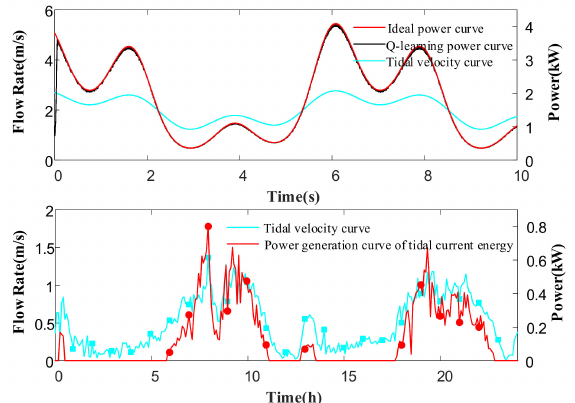
Figure 4. Power tracking of tidal current energy generation based on Q-Learning